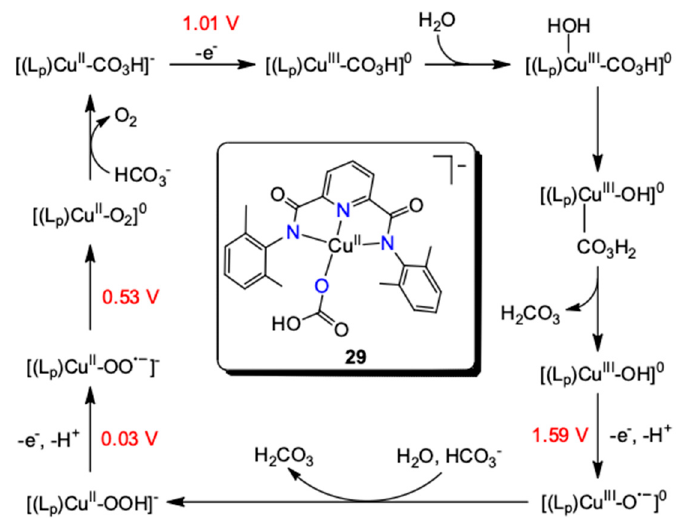
Figure 17. Structure for 29 and the proposed mechanism for water oxidation by this system [67].